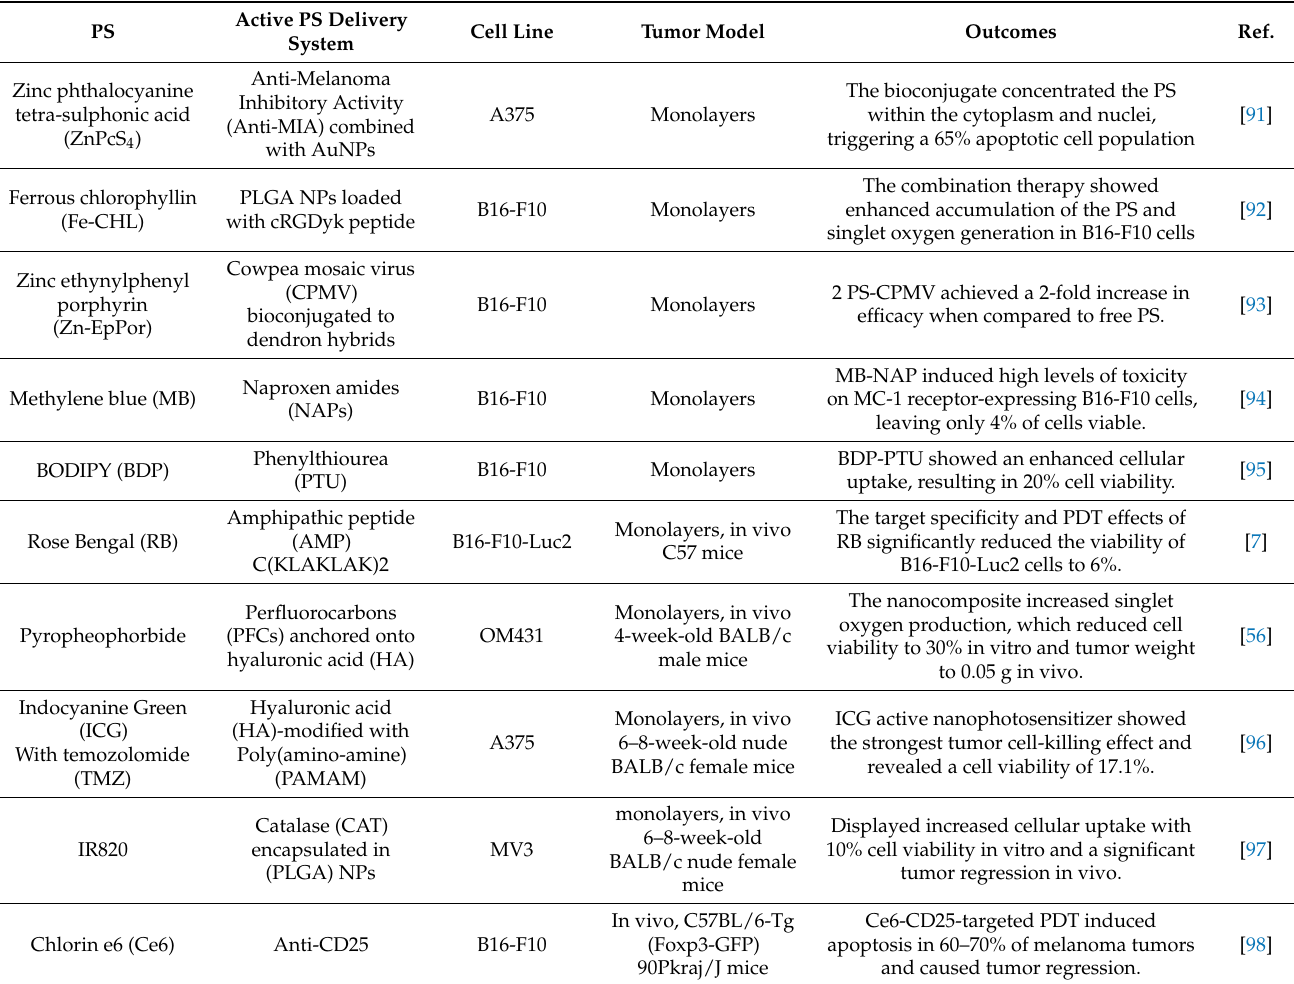
Table 4. Metastatic melanoma active targeting delivery systems.